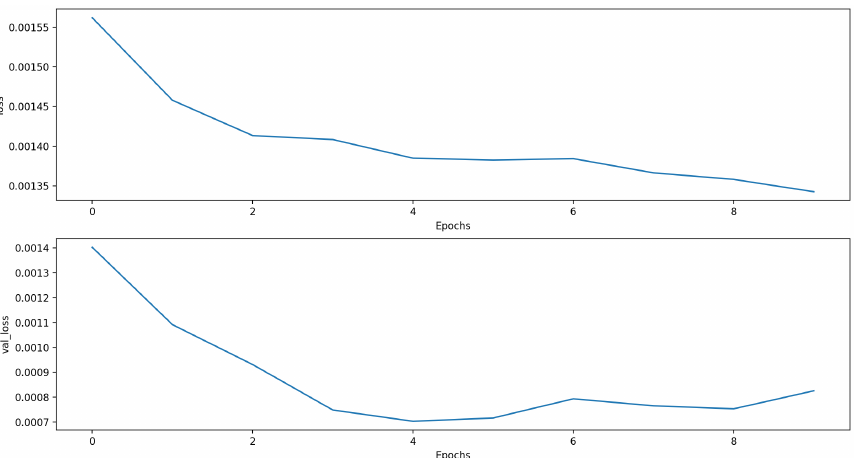
Figure 4. Training and validation MSE of the LSTM + Dense model with the best forecasting performance with the 12 h time horizon. loss denotes the training MSE, and val_loss represents the validation MSE.